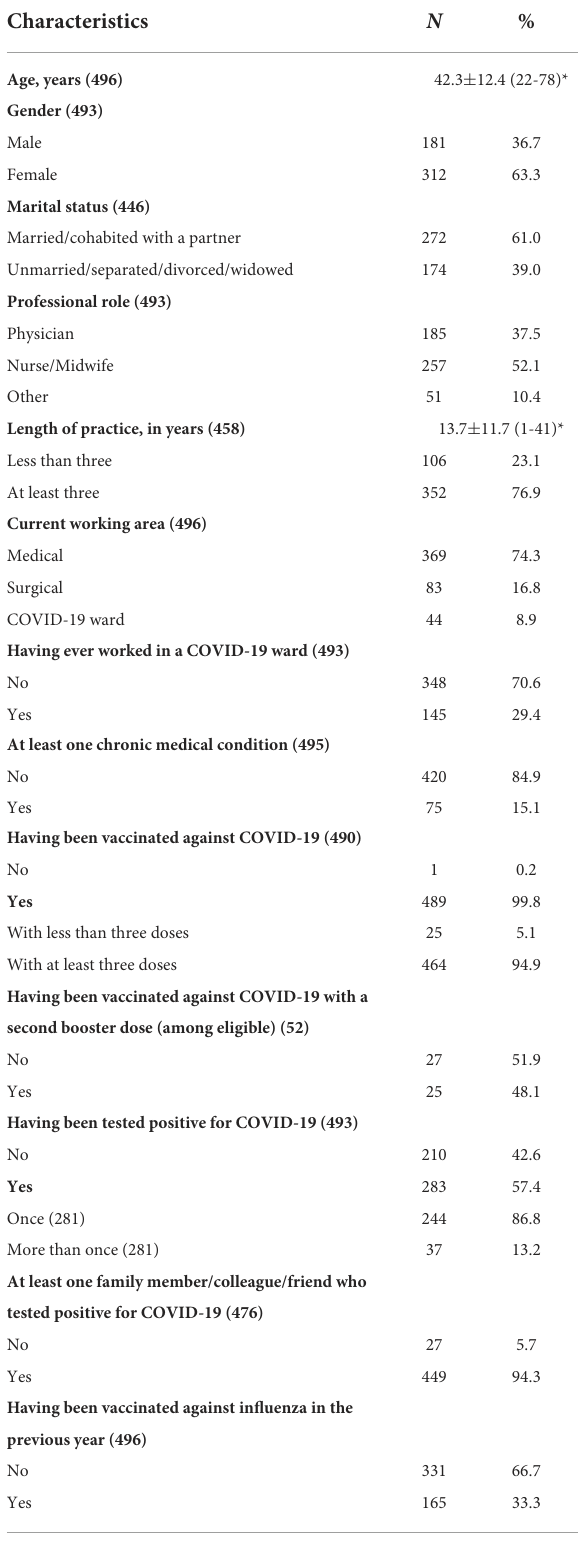
TABLE 1 Main sociodemographic and general characteristics of the sample.